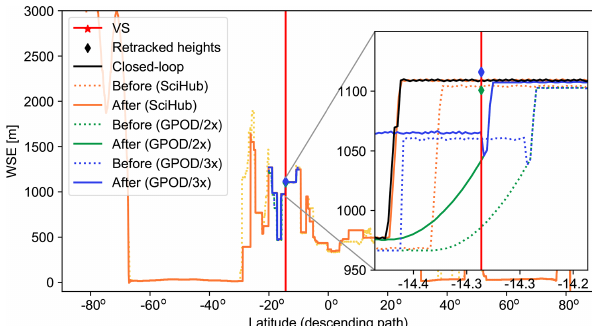
Figure 11. Tracker range for the three possible processing setups before and after the OLTC